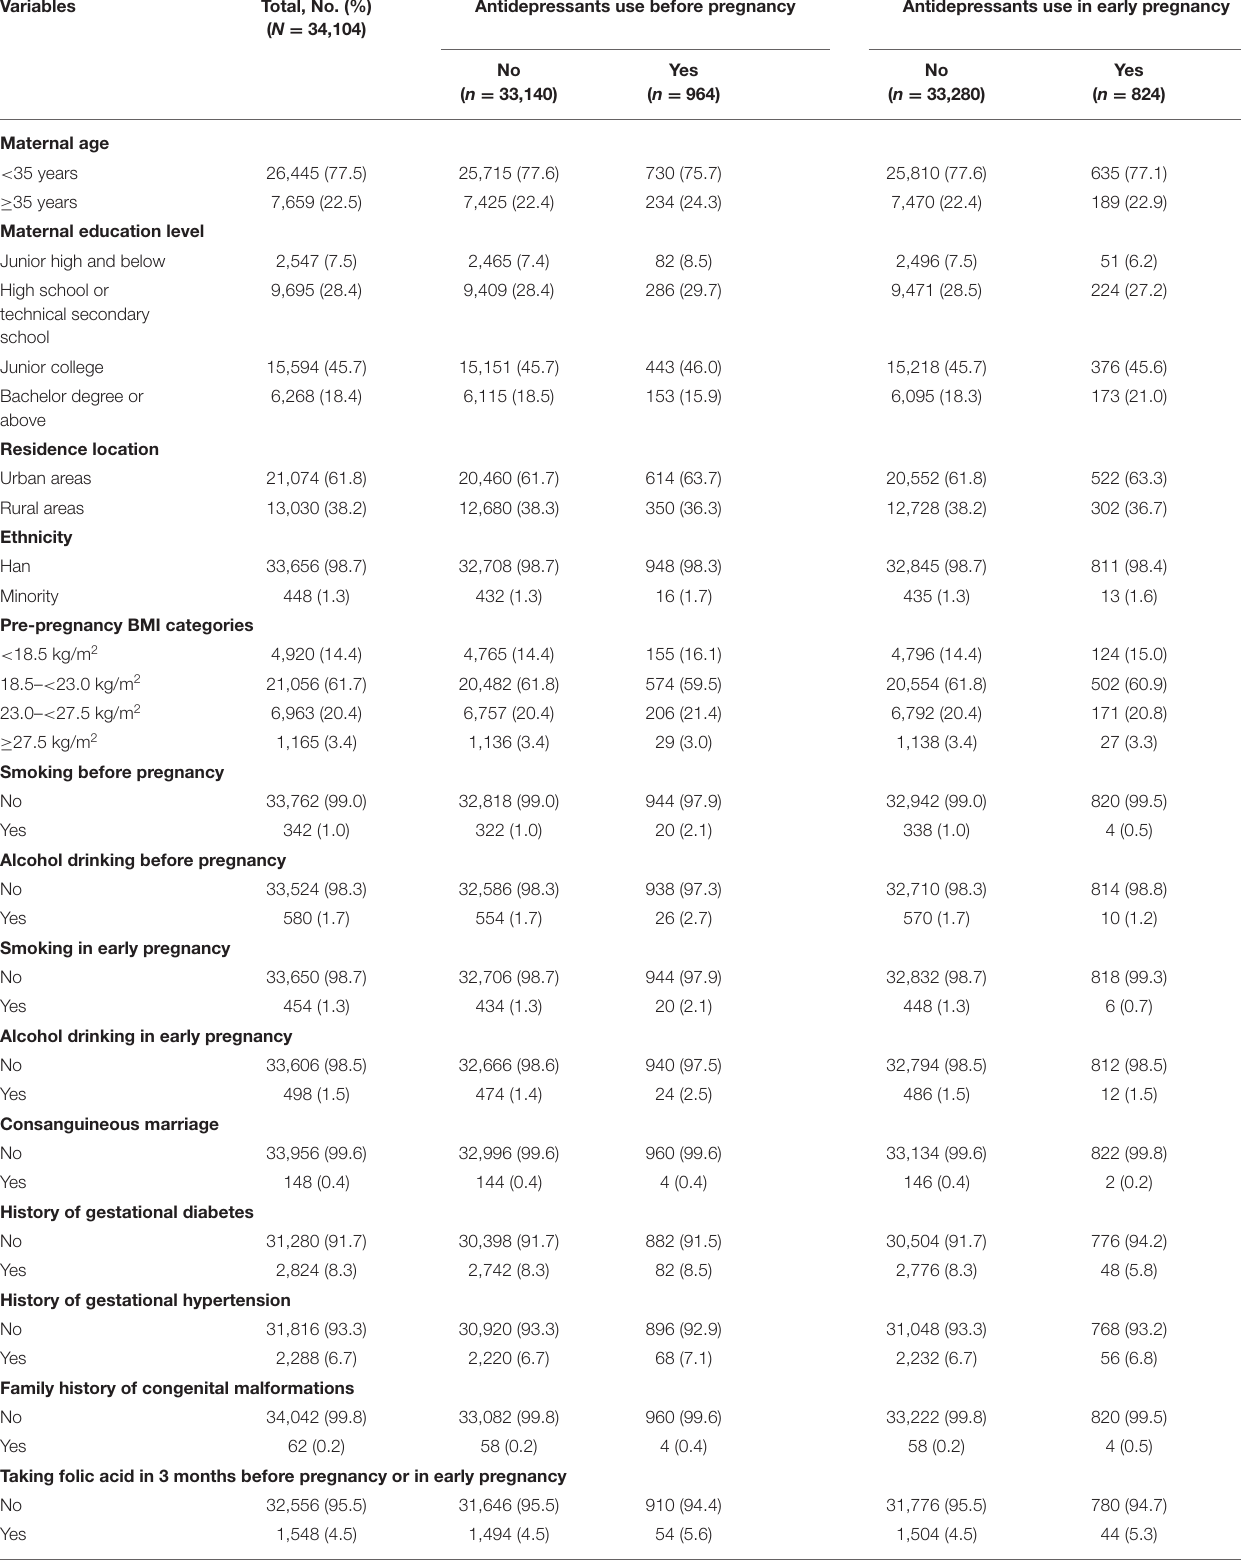
TABLE 2 | The distribution of baseline characteristics according to status of maternal antidepressant use before pregnancy or in early pregnancy.